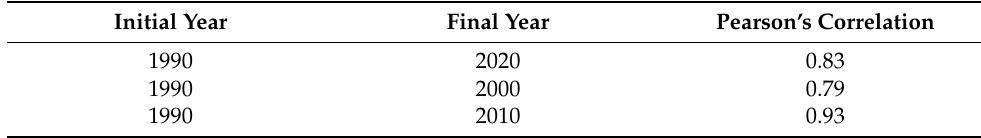
Table 2. Pearson’s correlation for different pairs of year.